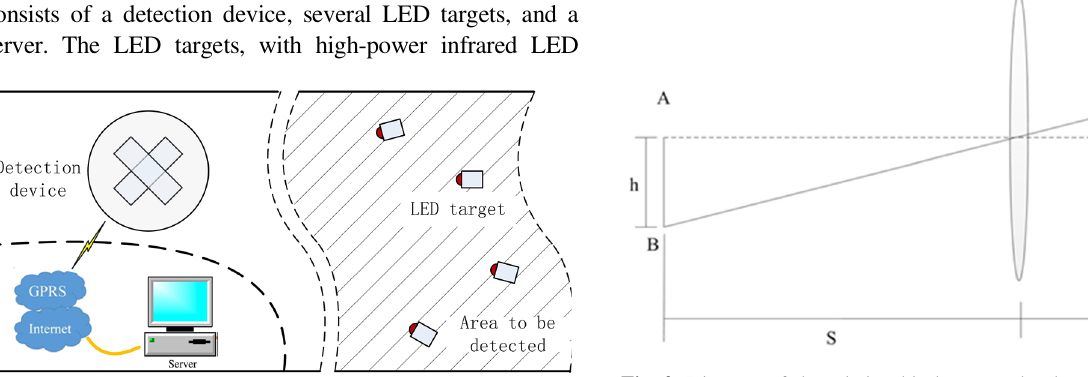
Fig. 1 Remote Subgrade Settlement Monitoring System composition